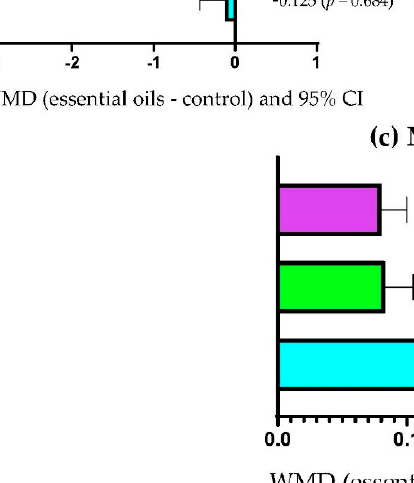
Figure 1. Subgroup analysis (subgroup = essential oils dose (mg/kg DM)) of the effect of essential oils on the diet of the small ruminants; WMD = weighted mean differences between essential oil treatments and